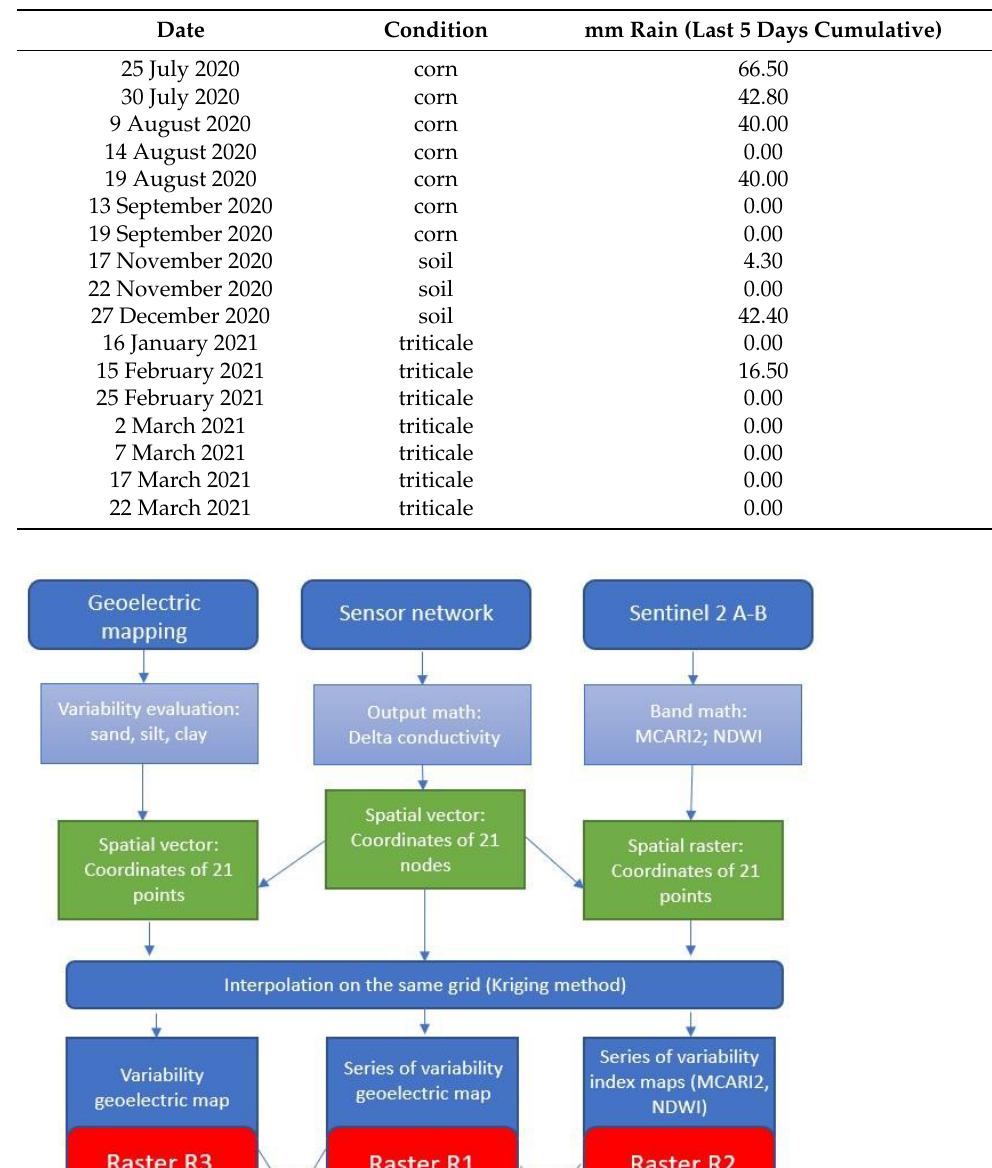
Table 1. Dates of availability of information used for this study.